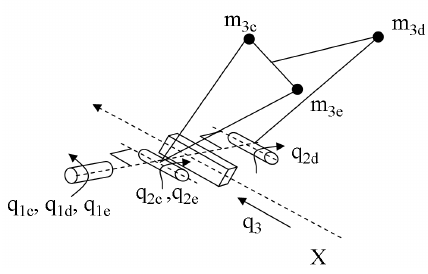
Figure 11: Definitions of the variables at the actuator side for the triple